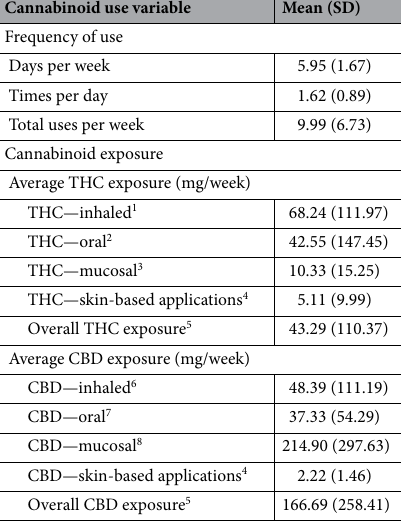
Table 2. Cannabinoid use characteristics. To demonstrate feasibility and applicability of CannaCount, averages and standard deviations are provided for frequency of use and cannabinoid exposure using data